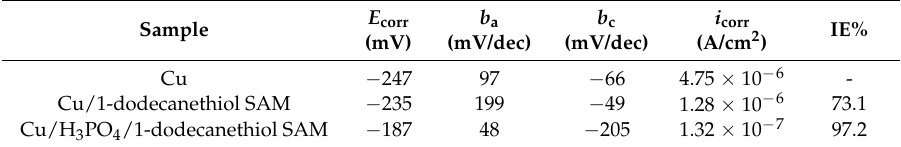
Table 4. Polarization parameters of copper electrode, copper electrode with 1-dodecanethiol SAM and H 3 PO 4 -treated copper electrode with 1-dodecanethiol SAM in 3.5% NaCl solution for 48